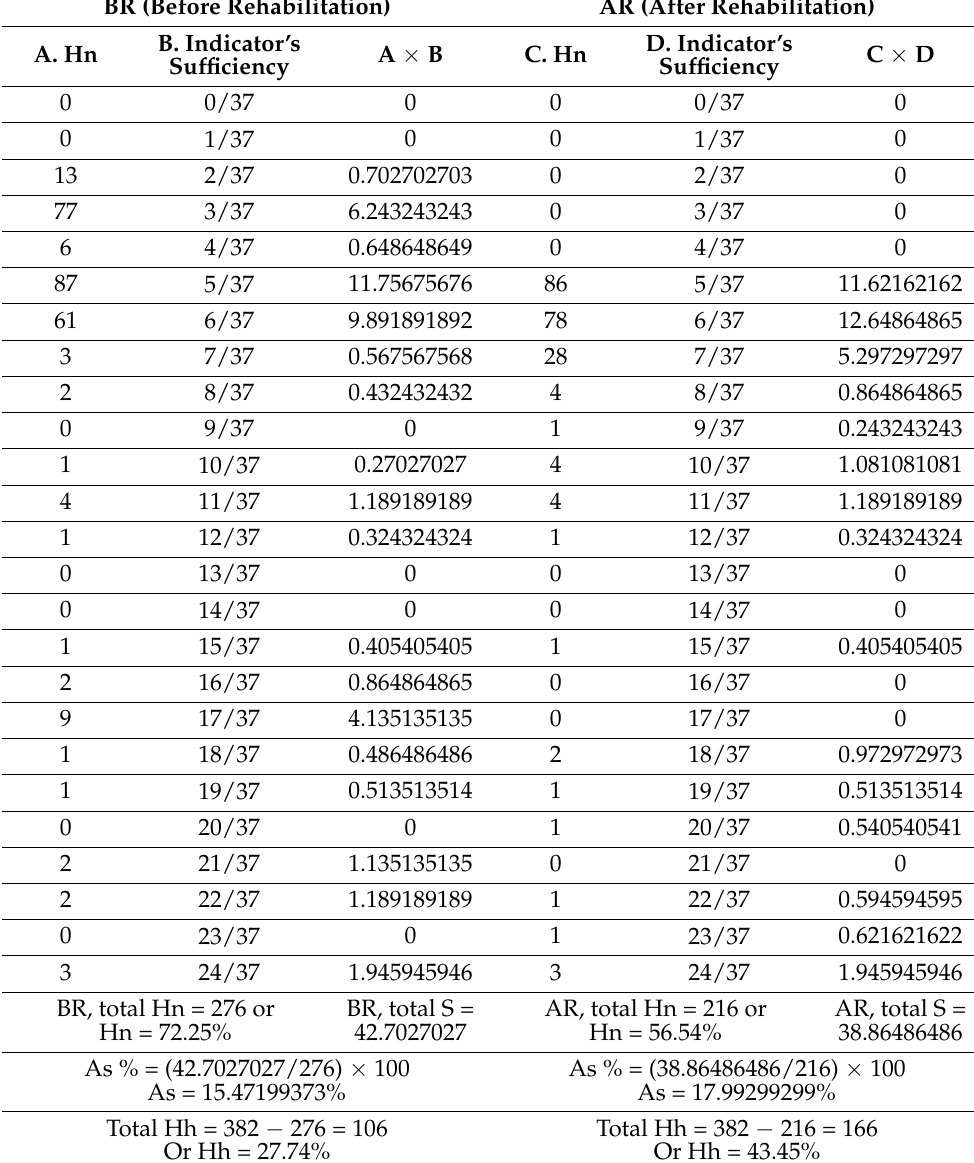
Table 4. Indicator’s sufficiency of the unhappy people BR and AR. Source: Compiled by the researchers. BR (Before Rehabilitation) AR (After Rehabilitation) A.